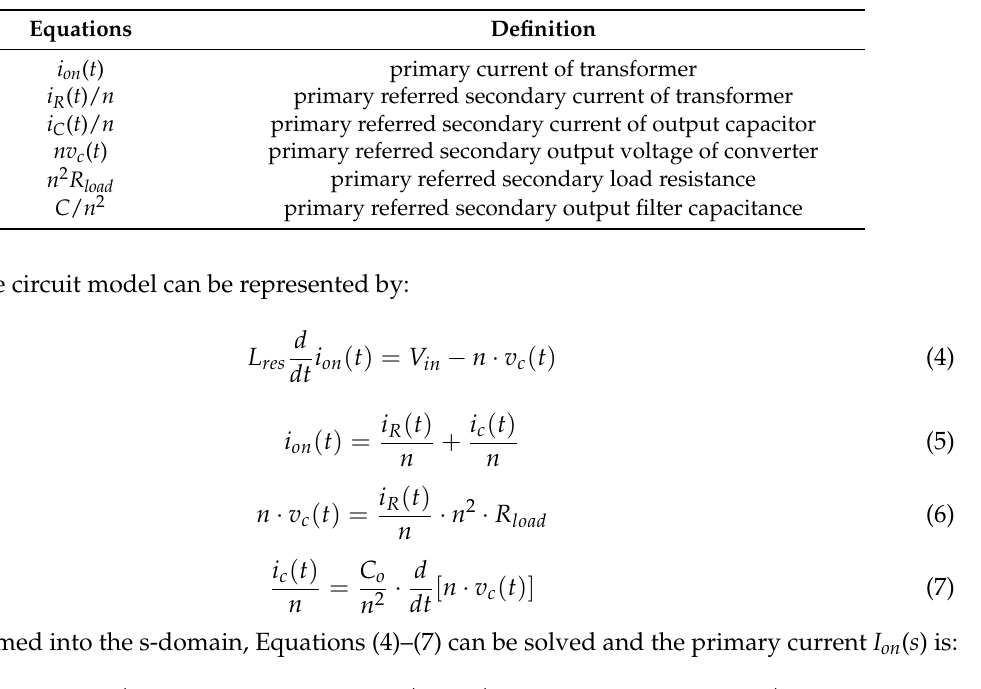
Table 2. Definition of common equations